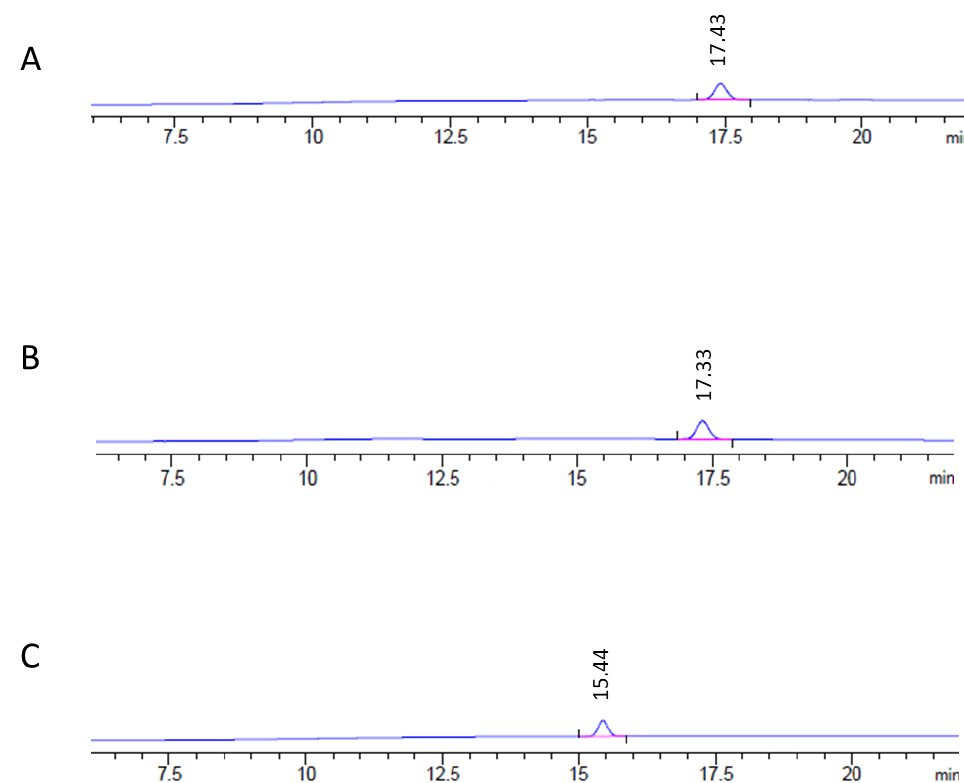
Figure 2. High-performance liquid chromatography with fluorescence detection coupled to a diode array detector (HPLC- FLD/DAD) chromatograms using an ergosterol standard (10 µg/mL) and the three different mobile phases tested in the present work. ( A ) Mobile phase 1, composed of methanol/acetic acid 0.05% ( v / v ) 90/10 ( v / v ); retention time: 17.43